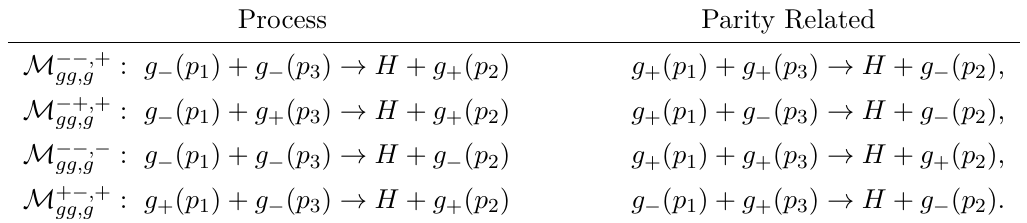
Table 2. Different kinematical crossings of the H → ggg amplitudes. The comma is used to separate the helicities of initial and final state